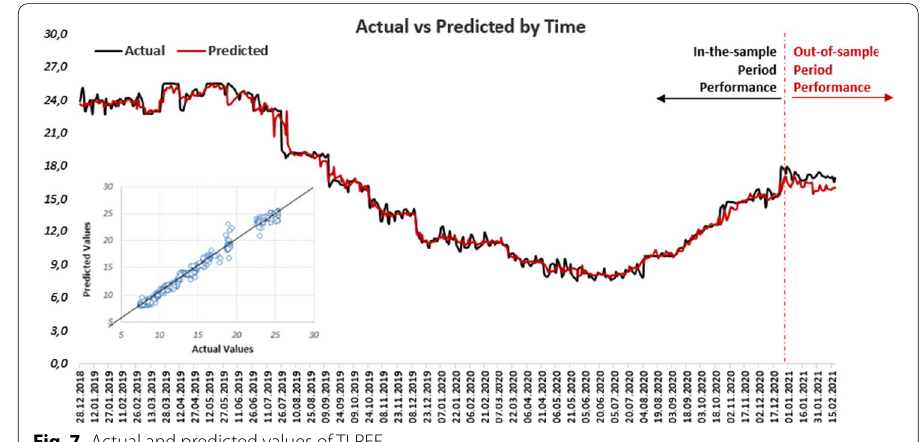
Fig. 7 Actual and predicted values of